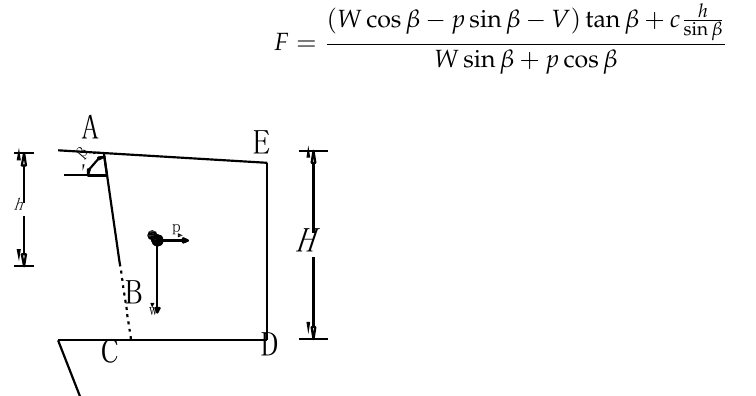
Figure 4. Stability calculation model of falling perilous rock.